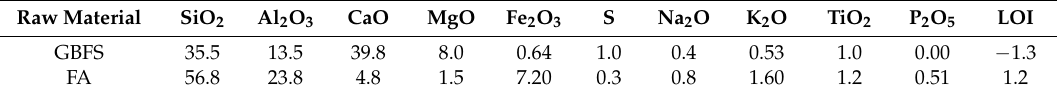
Table 1. Chemical composition of GBFS and FA measured with XRF